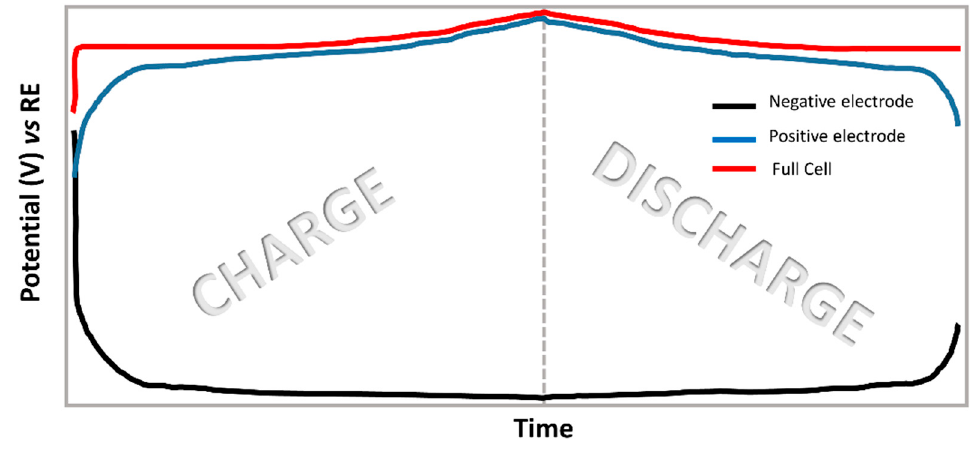
Figure 4. Typical examples of potential profiles obtained from galvanostatic cycling in three-electrode cell configuration.